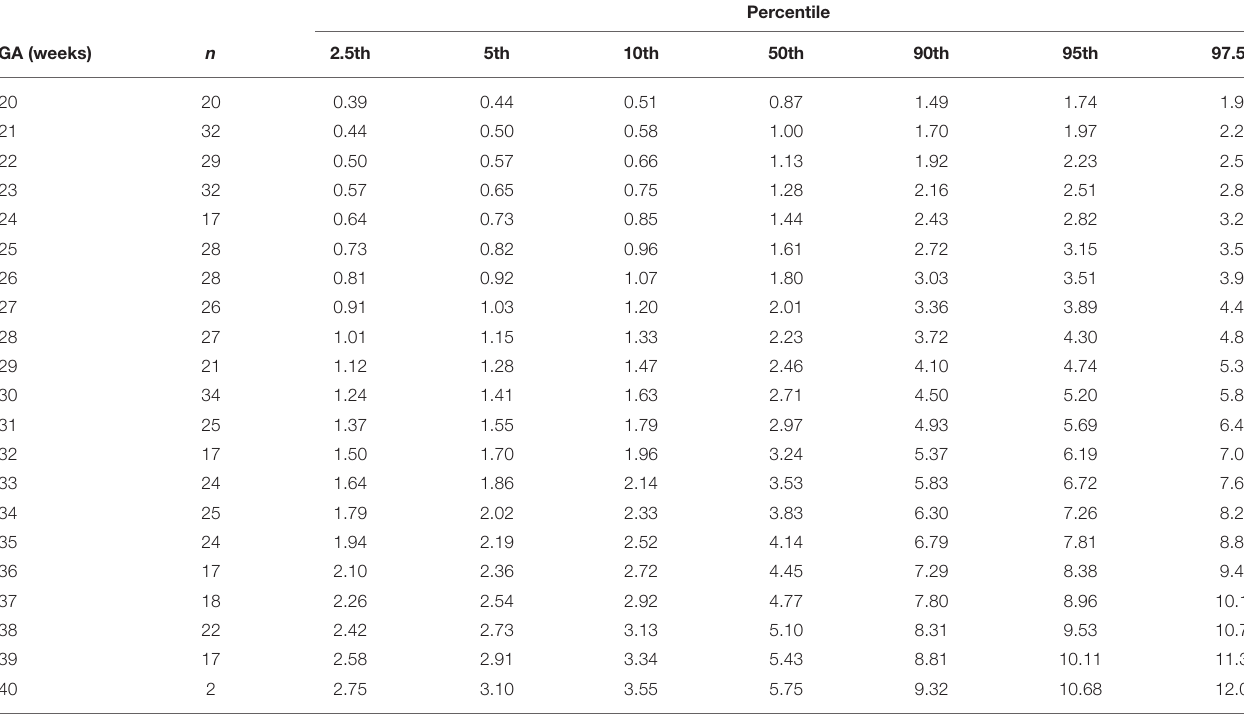
TABLE 5 | Percentiles of fetal superior vena cava volume blood flow normalized by head circumference (ml/min/cm) at 20–40 weeks of gestational age (GA).